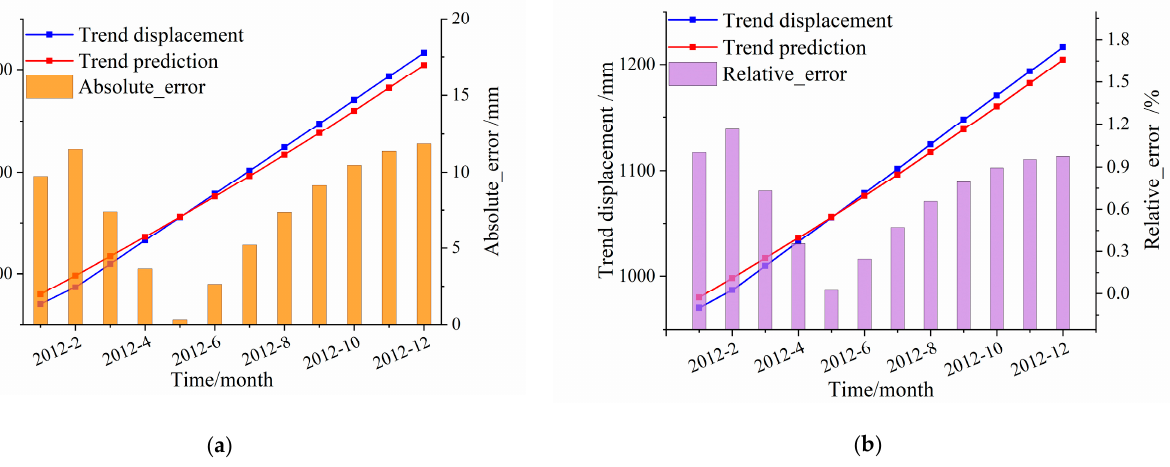
Figure 16. Prediction results of the trend displacement on ZG110. ( a ) Absolute error. ( b ) Relative error.